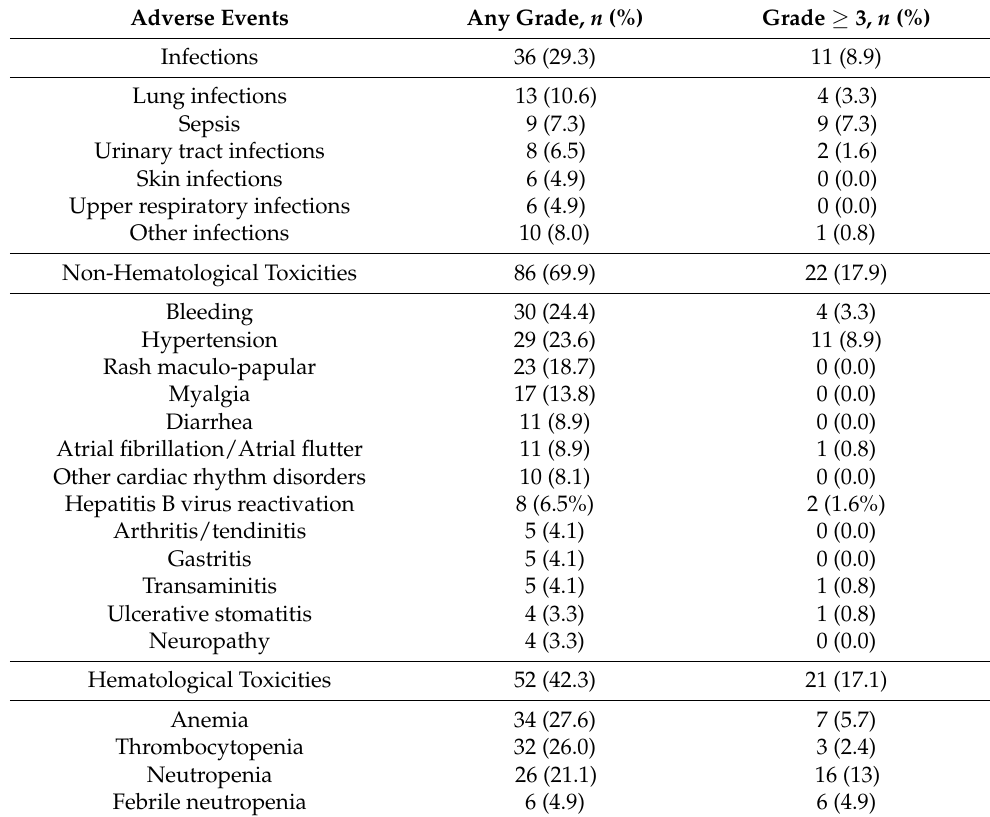
Table 8. Summary of adverse events reported for CLL patients while on ibrutinib monotherapy. Adverse Events Any Grade, n (%) Grade ≥ 3, n